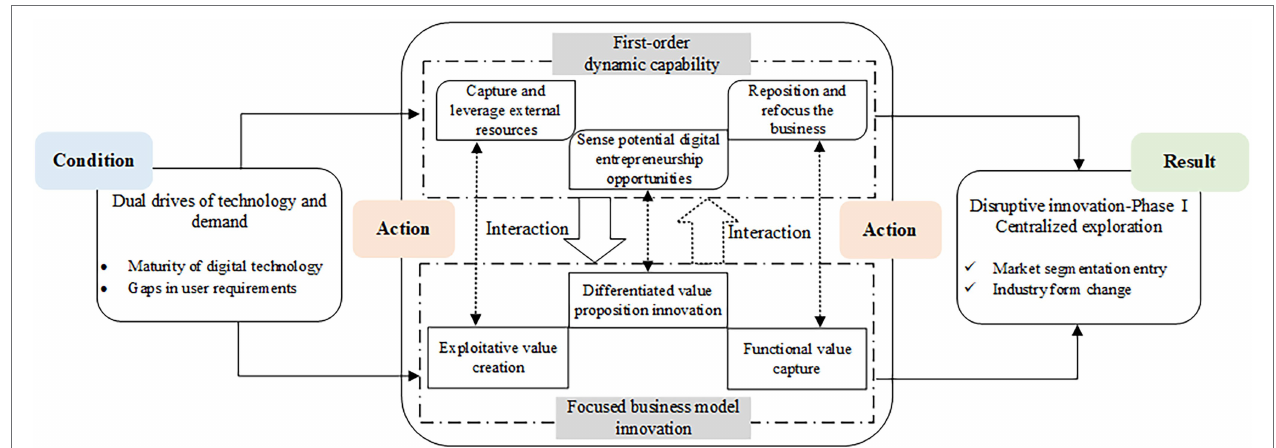
FIGURE 1 | The happening mechanism of ByteDance’s centralized exploration